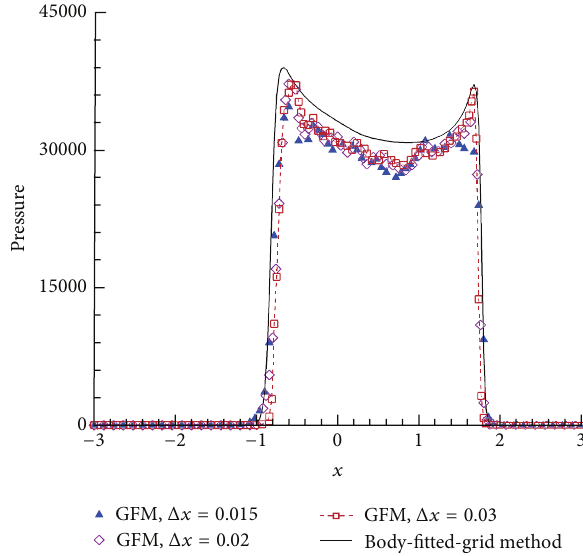
Figure 11: Pressure distribution in the immediate vicinity of rigid wall (Case